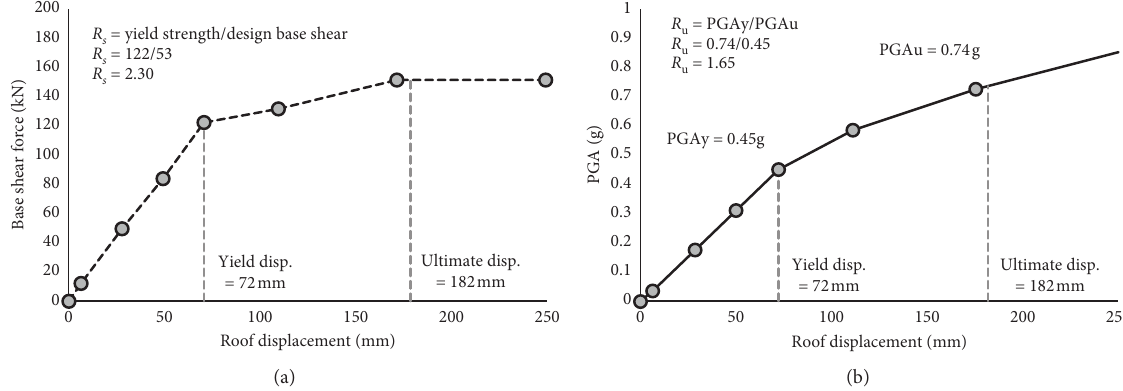
× R � 3.80. An example for Model-M s μ